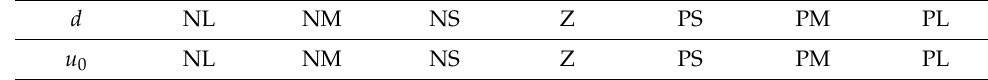
Figure 7. SIFLC control surface. 4. Parameter Optimization for Three Controllers with HPSO Algorithm In this section, the HPSO algorithm is developed and applied to optimize the con- troller parameters. Except for the SIFOFLC, the T-S FLC and FOPID control systems are